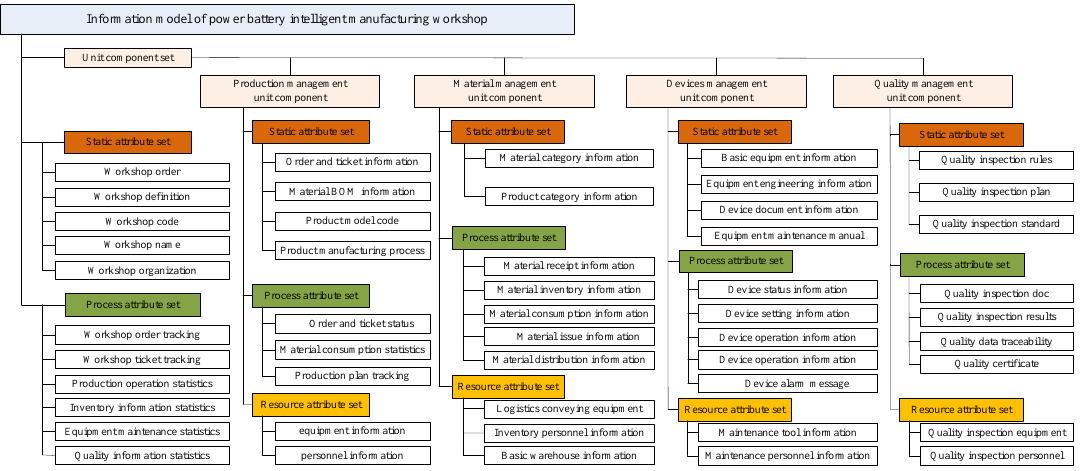
Figure 5. Schematic diagram of information model of lithium ion battery intelligent manufacturing workshop.